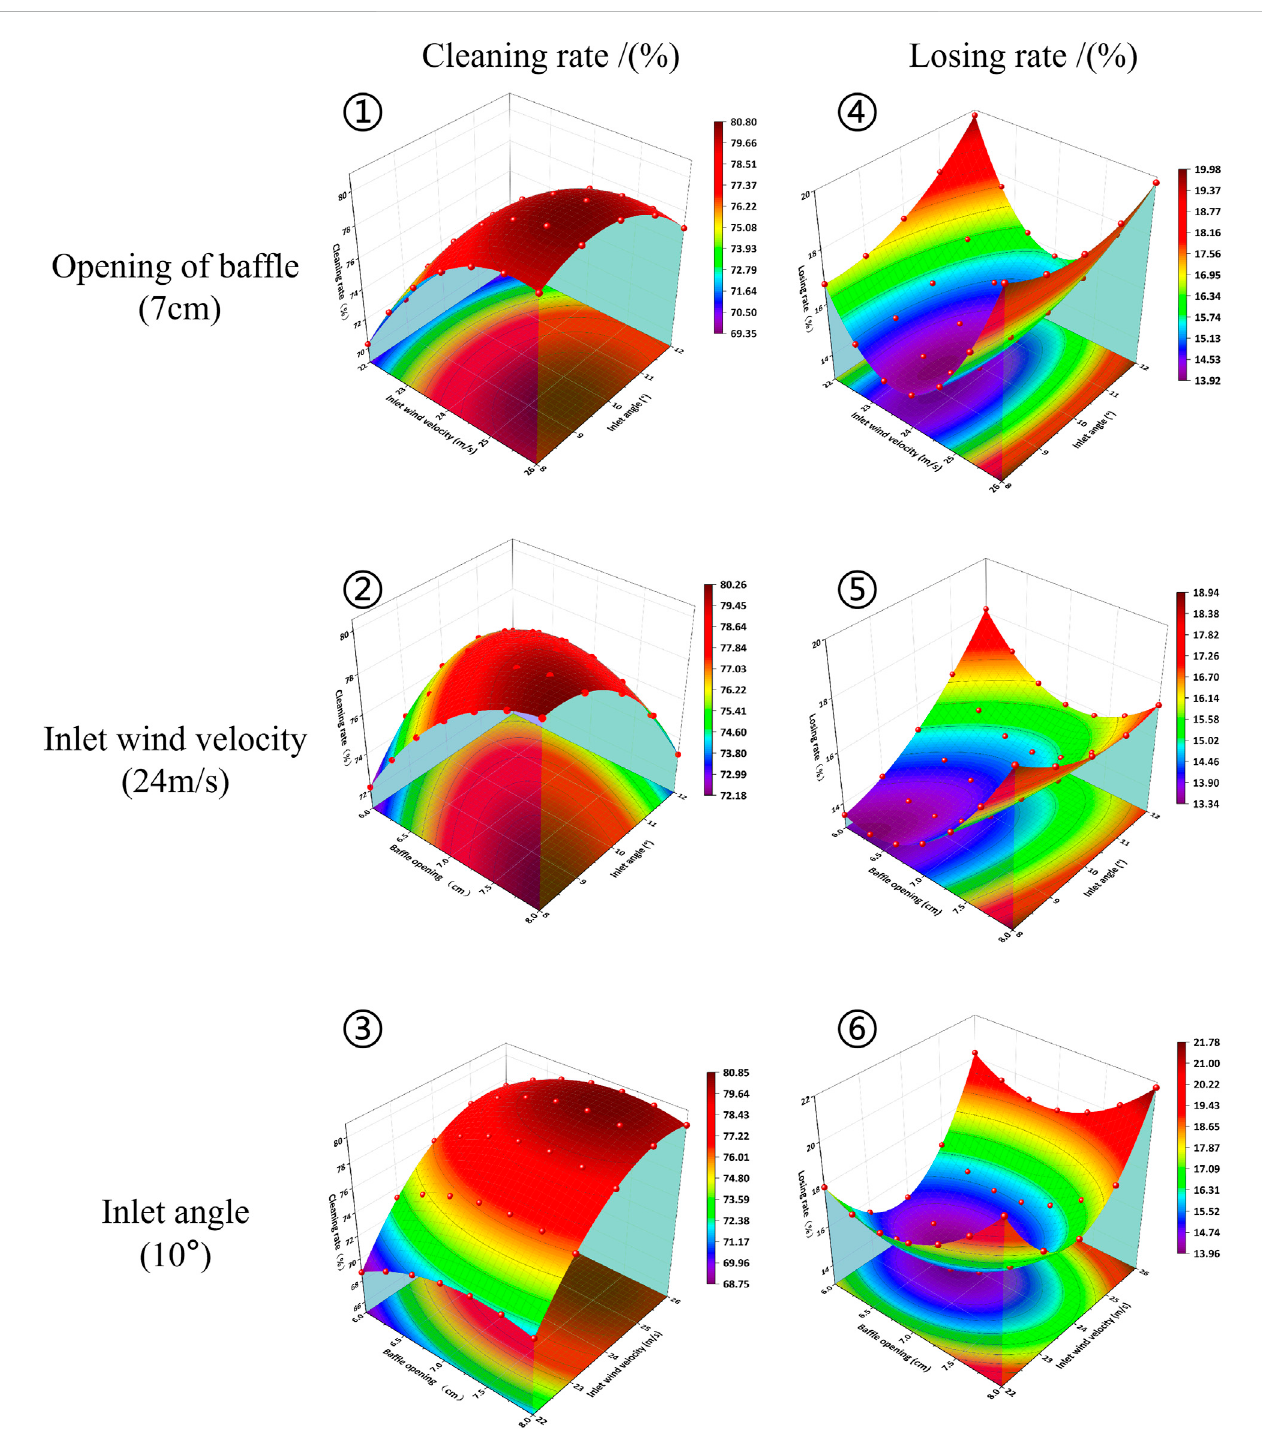
FIGURE 6 The effects of various factors on separation